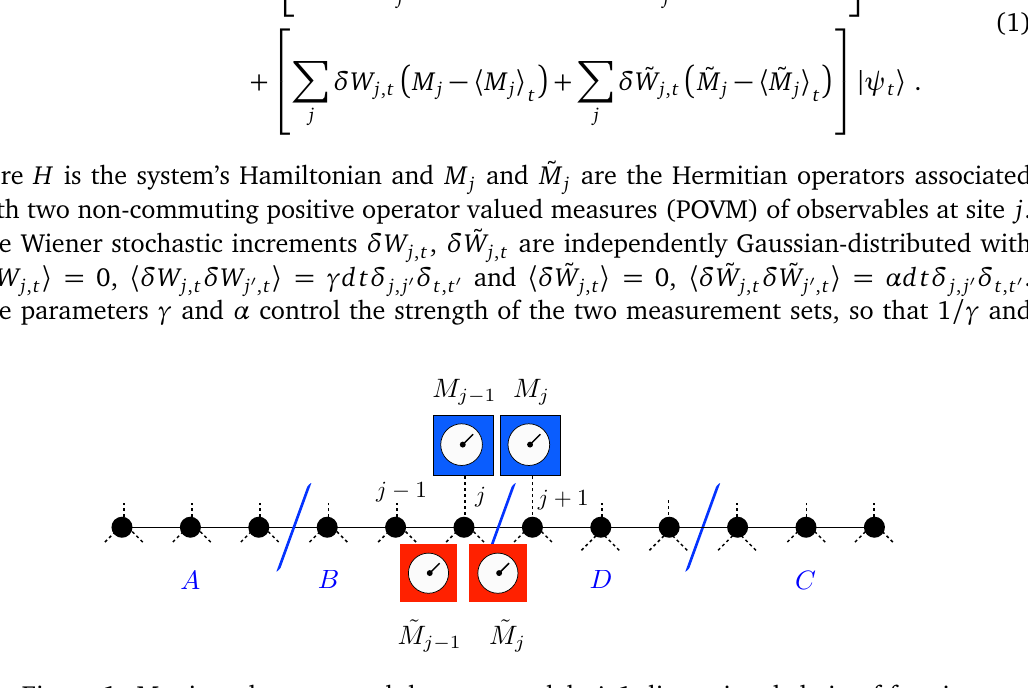
Figure 1: Monitored system and detector model. A 1-dimensional chain of fermion hopping between next-nearest sites (black dots) which are monitored by local detec- tors sensing the local occupation M (upper blue boxes) and the occupation of the j “Kitaev modes” ˜ M (lower red boxes). Blue lines separate the regions A , B , D and C , j each of equal size L / 4, used to define the topological entanglement entropy in Eq